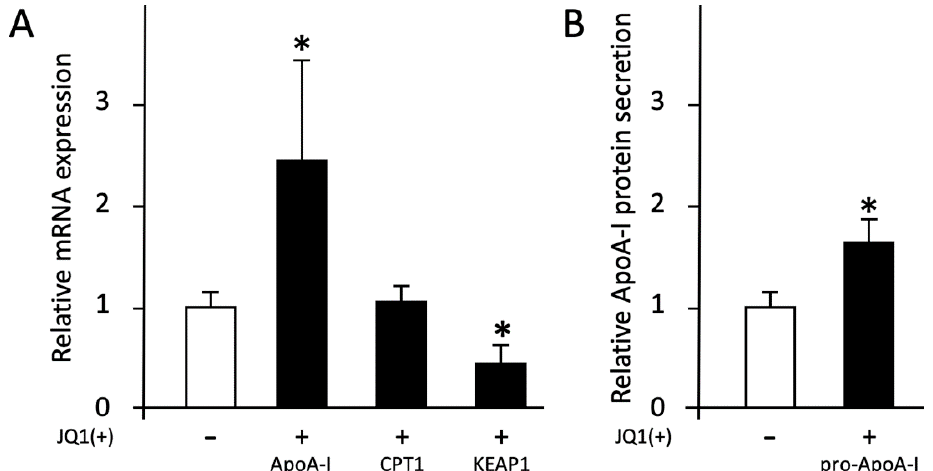
Figure 1. The cells are responsive to treatment. HepG2 cells were treated with BET inhibitor JQ1(+) (3µM) for 48 h as positive control indicated with the “+” or no JQ(+) indicated with the “-“. ( A ) Relative ApoA-I, CPT1, and KEAP1 mRNA expressions measured by qPCR. ( B ) Relative pro-ApoA-I protein secretions measured by ELISA. Results are presented as means with error bars indicating standard deviations. Data were normalized against the expression observed in the control condition, which was arbitrarily set at 1. This experiment was performed twice with each condition in quadruplicate. Differences between JQ1(+) and controls were tested with Mann-Whitney U tests. Significant difference ( p < 0.05) are marked with an asterisk.